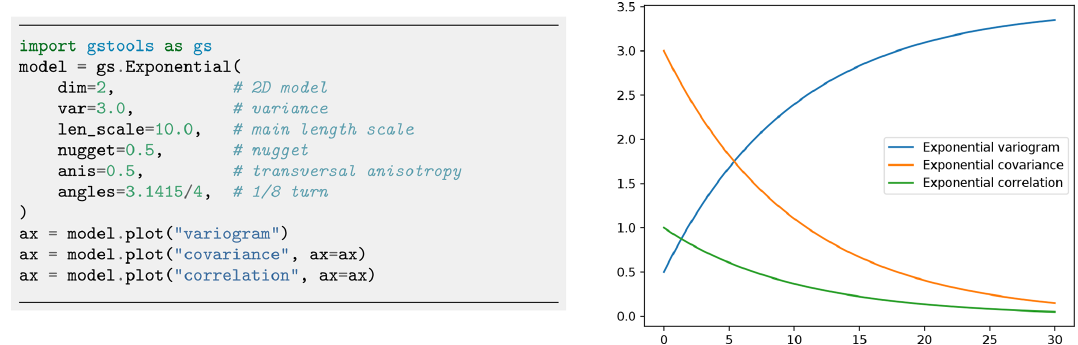
Figure 1. Initialization of an exponential covariance model given by cor (h) = exp ( − h) (Rubin, 2003). Note that the rescaling factor is 1 by default. The right panel shows the plot of the variogram, covariance and correlation functions of the model, which can be created with convenience plotting methods.